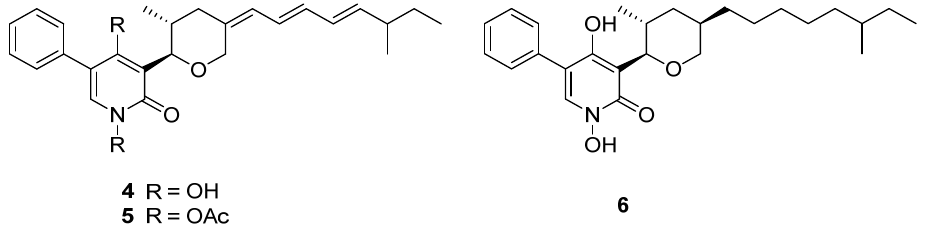
Figure 3. Structure of alkaloids 4 – 6 [16].